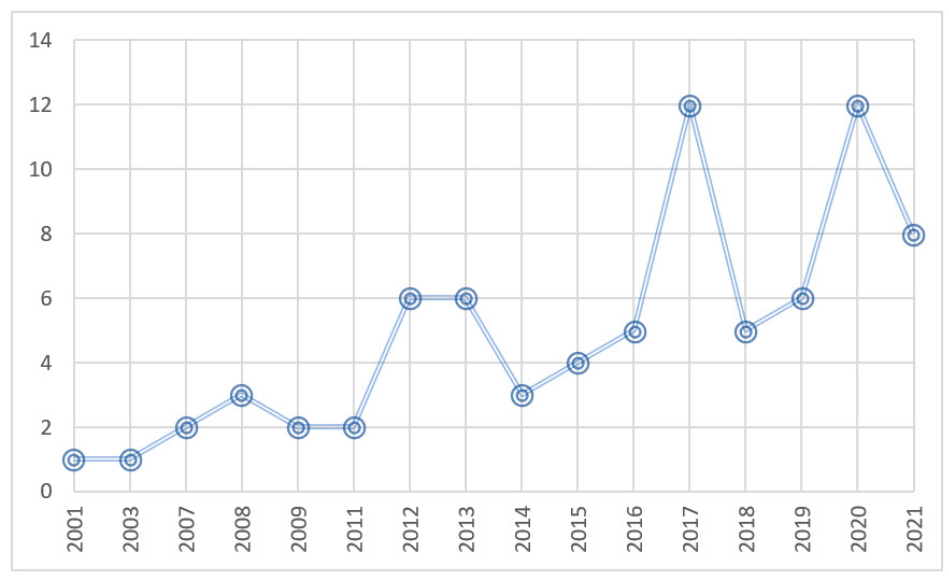
Figure 2. Number of publications per